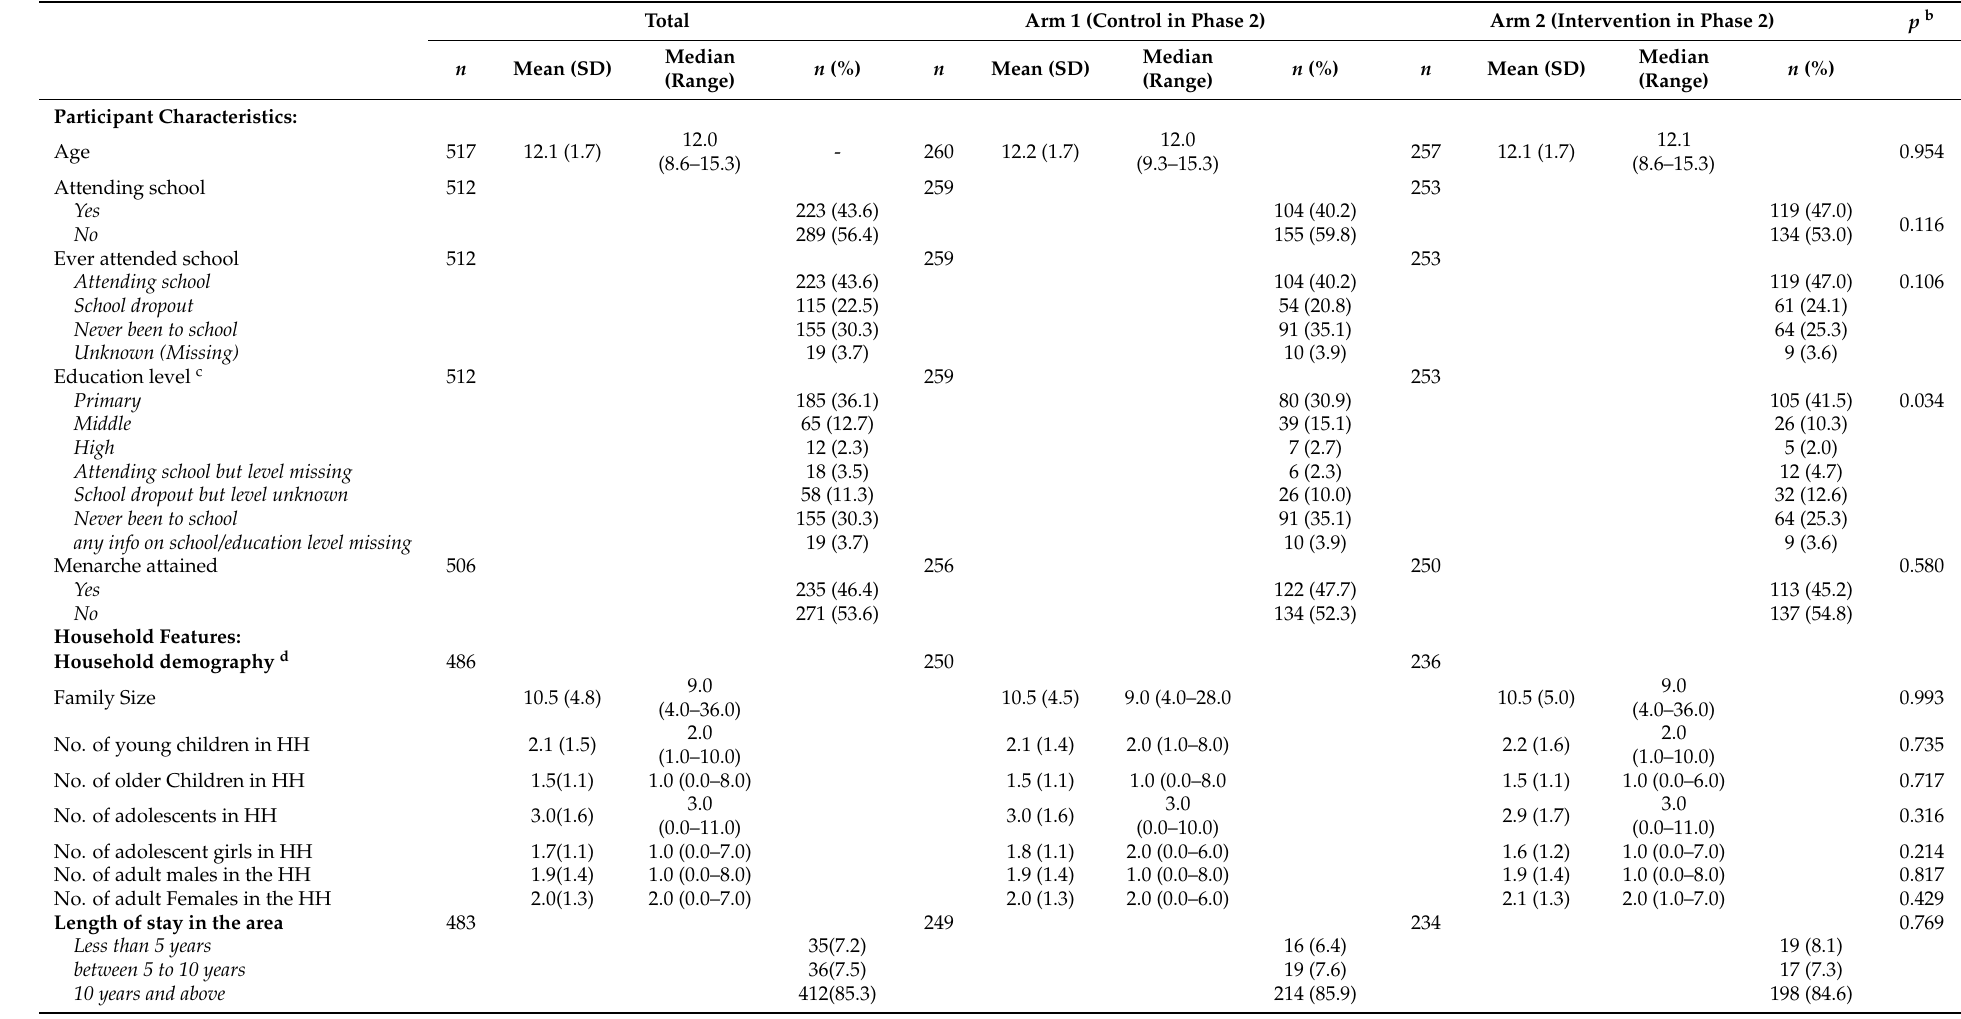
Table 1. Baseline characteristics of the participating households ( n = 486) and general characteristics of the recruited adolescent girls ( n = 517) a by the study